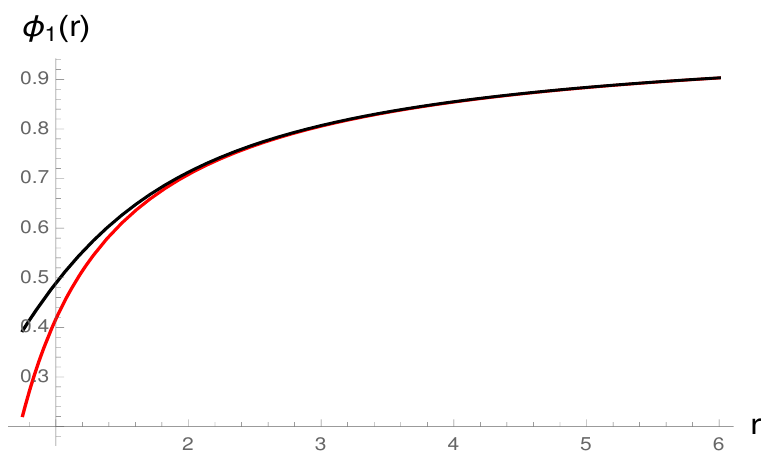
Figure 2 . The function (cid:30) 1 ( r ) (black) is compared with 1 (cid:0) 0 : 5835 =r